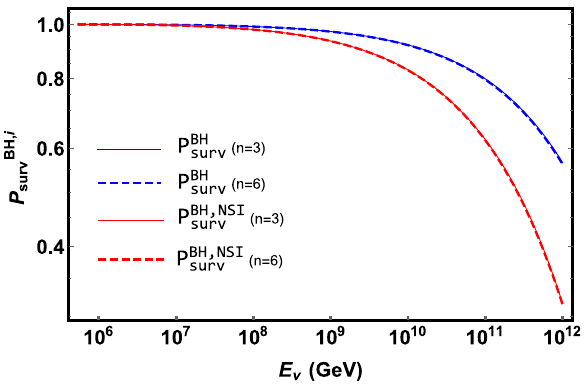
Fig. 4 Variation of BH survival probability, P BH , i sur v , with energy E ν of a particular neutrino ν i for the cases, n = 3 and